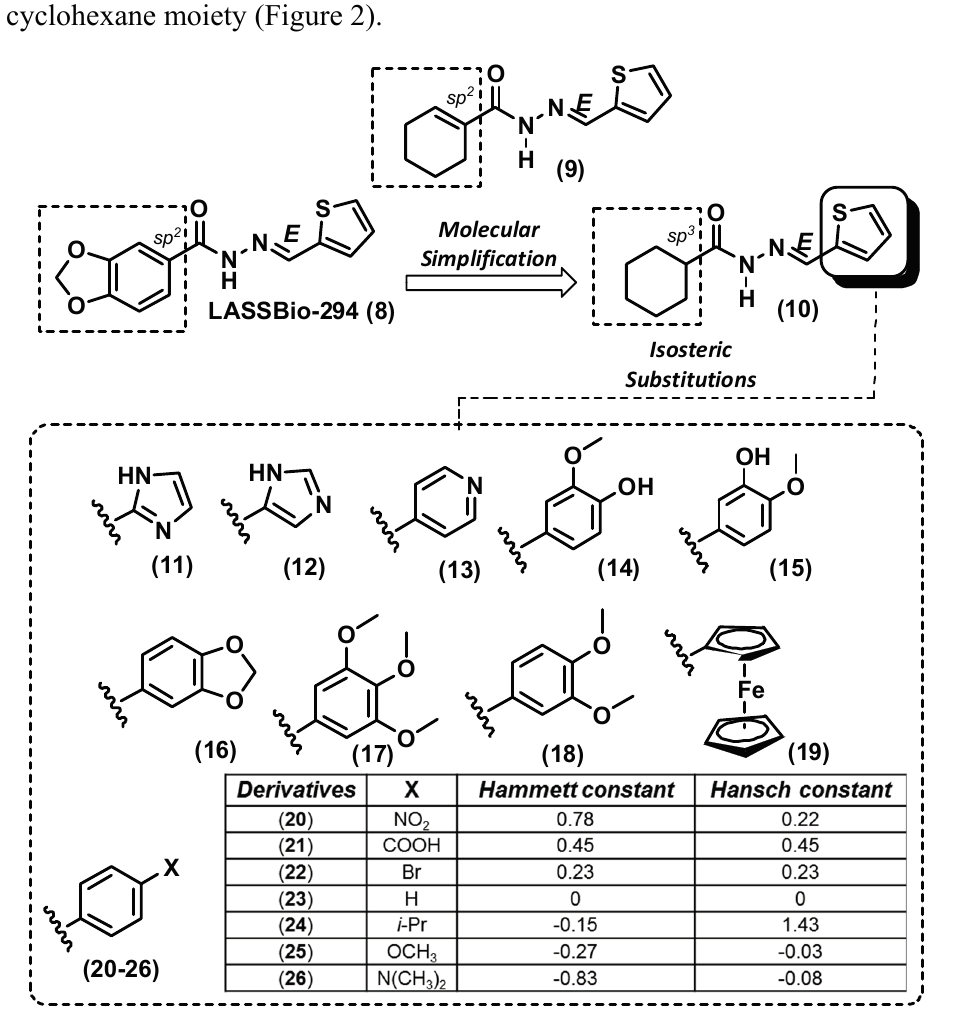
Figure 2. Design concept of novel cyclohexyl- N -acylhydrazones 10 – 26 from the prototype LASSBio-294 and its cyclohexenyl analogue 9